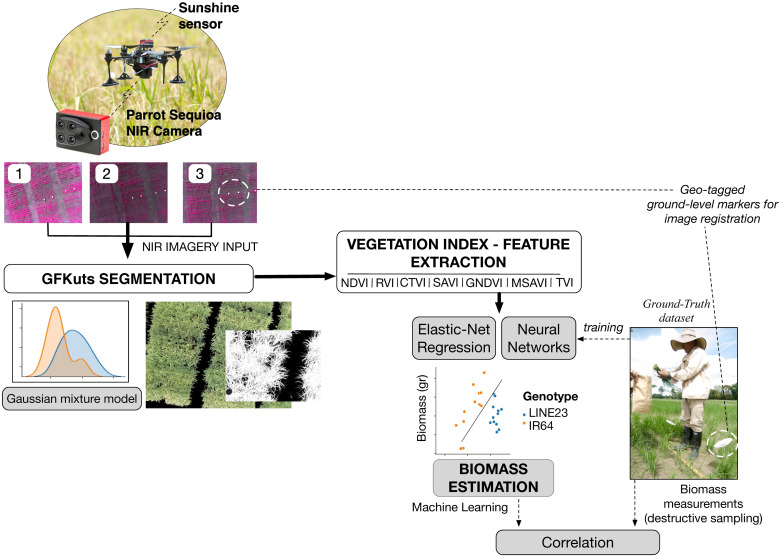
UAV-driven remote sensing of above-ground biomass in rice crops based on NIR imagery.